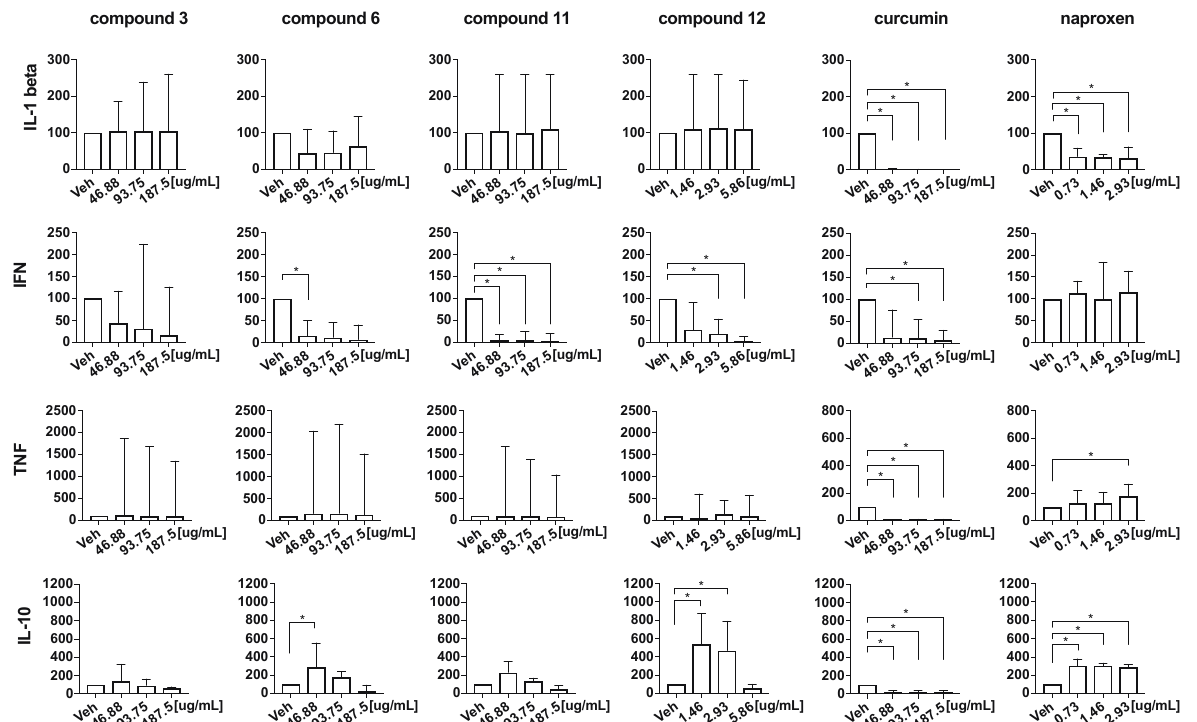
Figure 5. Summary of IL-1 β , IFN- γ , TNF- α , and IL-10 analyzes in cell culture supernatants from the PBMC stimulation with LPS in the presence or absence of the monocarbonyl analogs of CUR, CUR and naproxen. PBMCs were stimulated with LPS for 24 h in the presence or absence (veh) of selected compounds ( 3 , 6 , 11 , 12 , CUR, and naproxen). The levels of Il-1 β , IFN- γ , TNF- α , and IL-10 were measured in cell culture supernatants using commercially available ELISA sets. The results are presented as a percentage of LPS stimulated control (veh) n = 5; the Wilcoxon test was used, * p < 0.05.